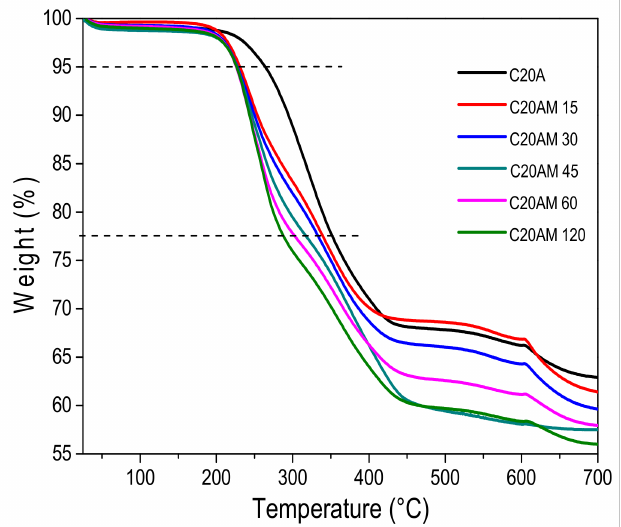
Figure 2. Termogravimetric analysis of the nanoclay C20A and modified nanoclay C20A with 1,4-diaminobutane